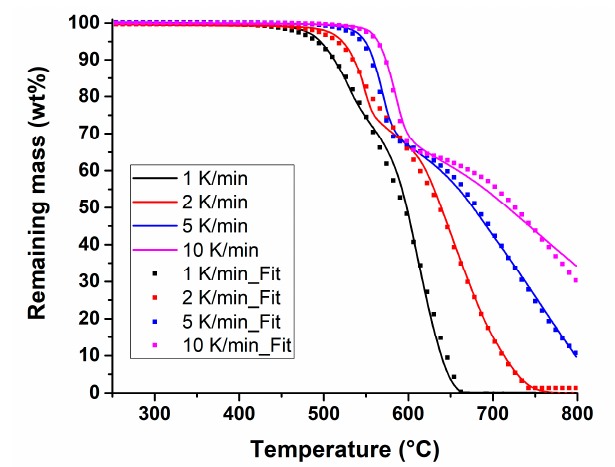
Figure 12. Best fit of the TG data for the three-step reaction models in Scheme 2, with the parameters given in Table 3. The curves represent the experimental data and the symbols represent the model.